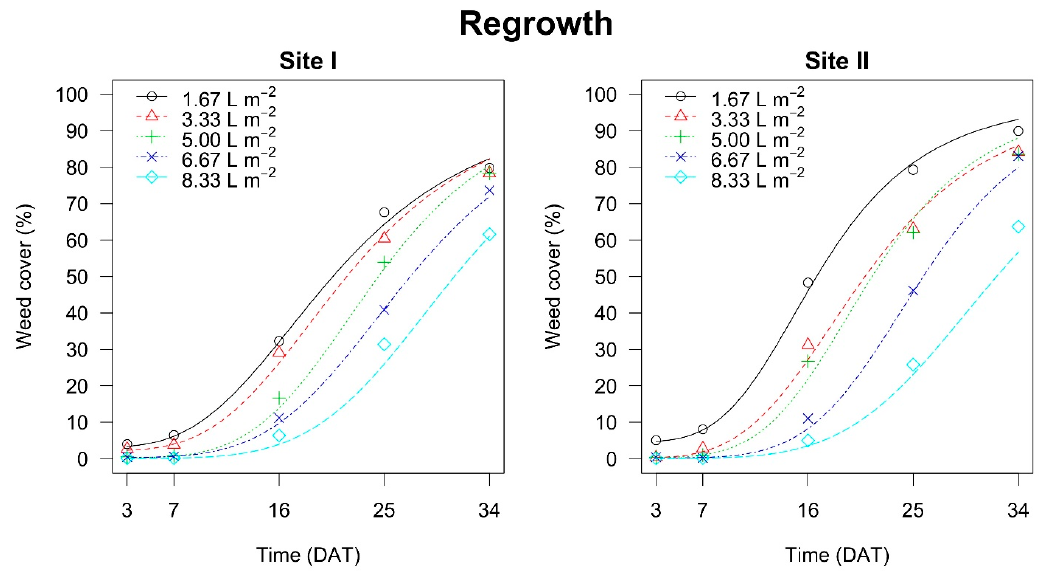
Figure 6. Log-logistic regression curves with average points of weed cover percentage as a ff ected by the foam dose (0, 1.67, 3.33, 5.00, 6.67 and 8.33 L m − 2 , respectively) and the evaluation date in the two-site field experiment infested with Taraxacum o ffi cinale (Weber) and Plantago lanceolata (L.). DAT: days after the treatment. The parameters of the non-linear regression curves (Equation (1)) are reported in Table 6. Regrowth was from weeds death (i.e., three days after hot foam application) to one month after death. Table 6. Parameters and standard errors (SE) of the log-logistic regression model (Equation (1)) and e ff ective times (days) estimated for reaching 10%, 25% and 50% weed cover regrowth (ET 10 , ET 25 , and ET 50 , respectively) as a ff ected by the di ff erent foam doses at di ff erent evaluation date in the two-site field experiment infested with Taraxacum o ffi cinale (Weber) and Plantago lanceolata (L.). The non-linear regression curves are plotted in Figure 6. Regrowth was from weeds death (i.e., three days after hot foam application) to one month after